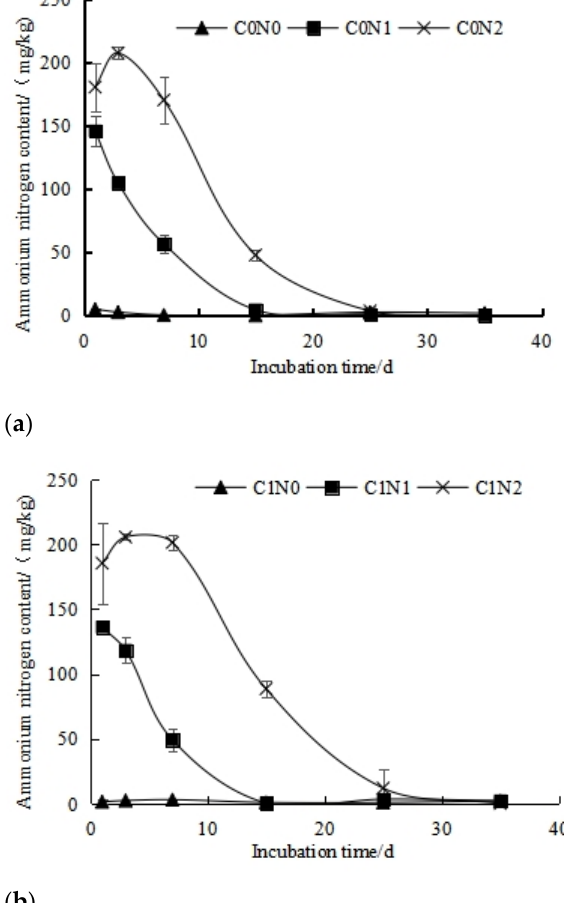
Figure 4. Changes in the ammonium nitrogen content in saline soil during cultivation. ( a ) Without straw returning. ( b ) Straw returning. When straw was returned to the field, the content of ammonium nitrogen in the sa- line soil under the C1N0 treatment without the application of nitrogen was 13.79 mg/kg on Day 0 of the incubation, which continued to decrease with the incubation time until it reached 2.20 mg/kg on Day 35. The content of ammonium nitrogen in the saline soil under each nitrogen application treatment was significantly higher than that under the C1N0 treatment without the application of nitrogen. The content of ammonium nitrogen in the saline soil was significantly higher than that under the no-nitrogen treatment. During the